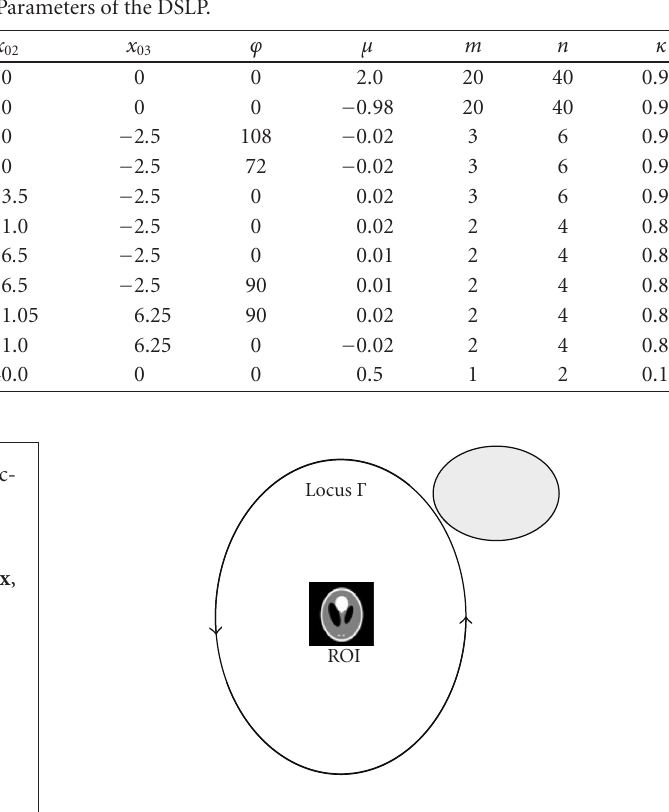
Figure 4: Exact fan-beam lambda tomography with an object out- side the scanning trajectory.